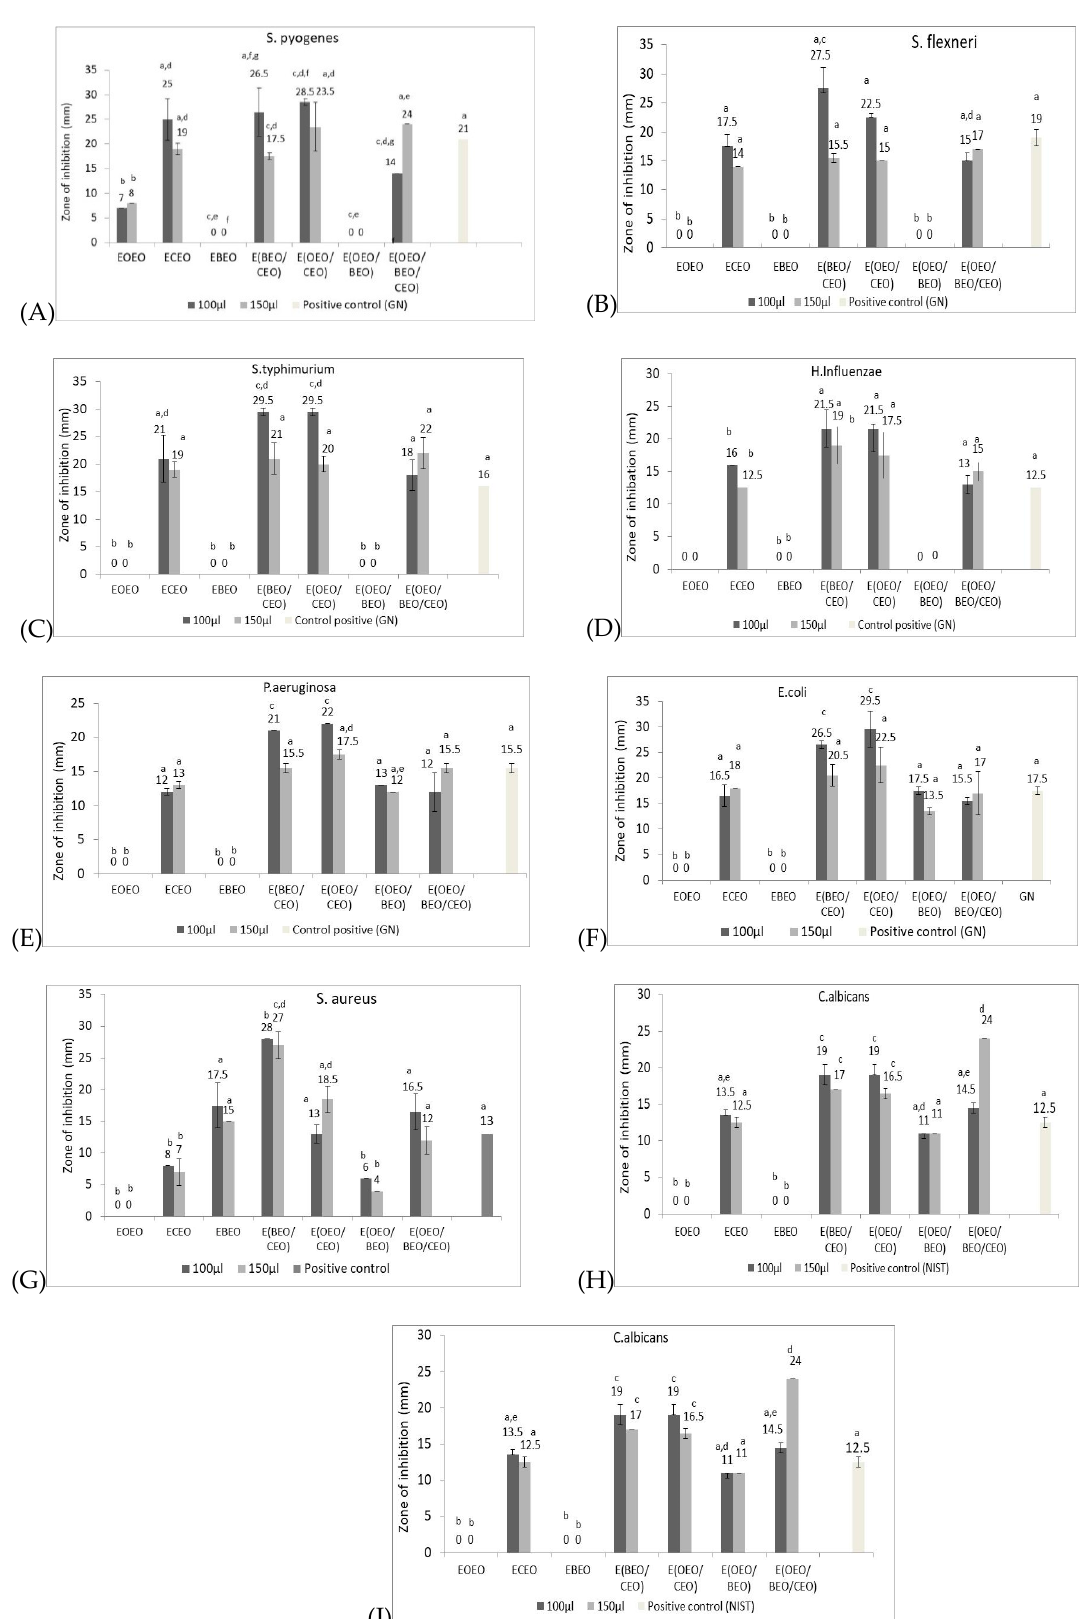
Figure 1. Antimicrobial activity of natural preparations expressed as Zone of inhibition (mm). ( A ) S. pyogenes , ( B ) S. flexneri, ( C ) S. typhimurium; ( D ) H.influenzae; ; ( E ) P.aeruginosa ; ( F ) E.coli ; ( G ) S.aureus; ( H ) C.albicans; ( I ) C.parapsilopsis (different letters in columns indicate significant differences between values according to the T test, p < 0.05).